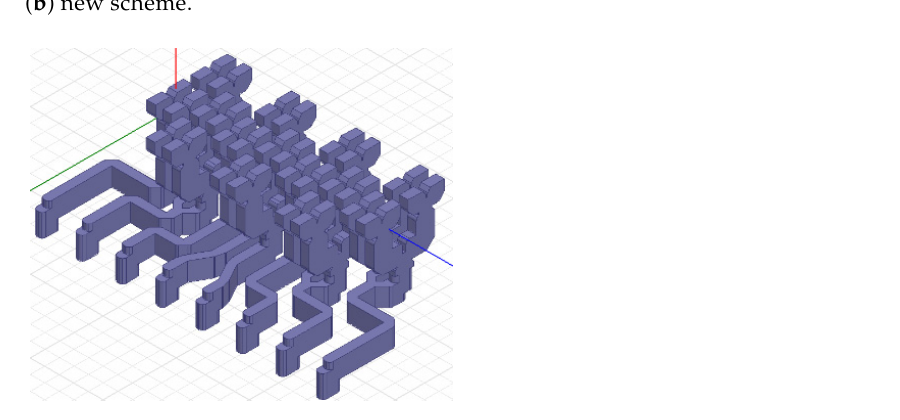
Figure 11. The W-Band active phased array antenna.